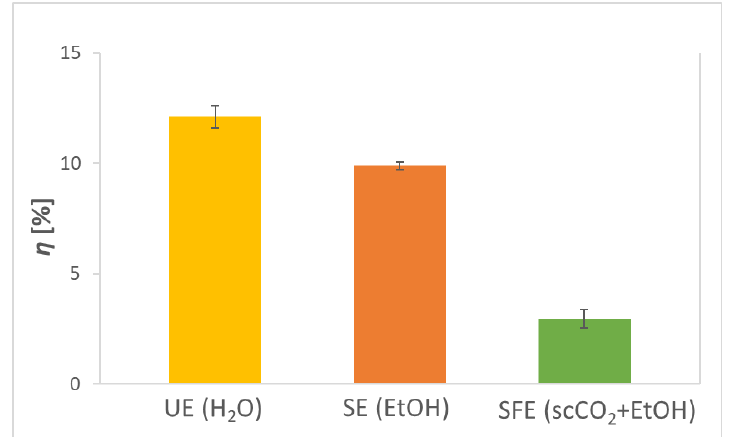
Figure 1. Extraction yields ( η ) obtained by ultrasonic extraction (UE; solvent H 2 O), Soxhlet extraction (SE; solvent EtOH), and supercritical fluid extraction (SFE; solvent scCO 2 , co-solvent EtOH) of avocado seed (AS).